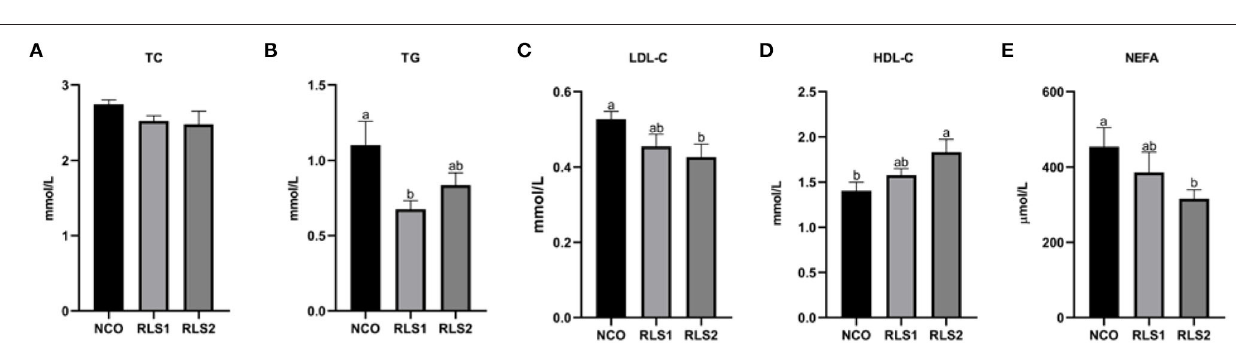
genes, namely carnitine palmitoyltransferase-1 and 2 ( CPT-1 and CPT-2 ), and peroxisome proliferator-activated receptor-gamma coactivator-1 α ( PGC-1 α ), were significantly higher in RLS2 rats than those in NCO rats ( P < 0.05). However, differences in